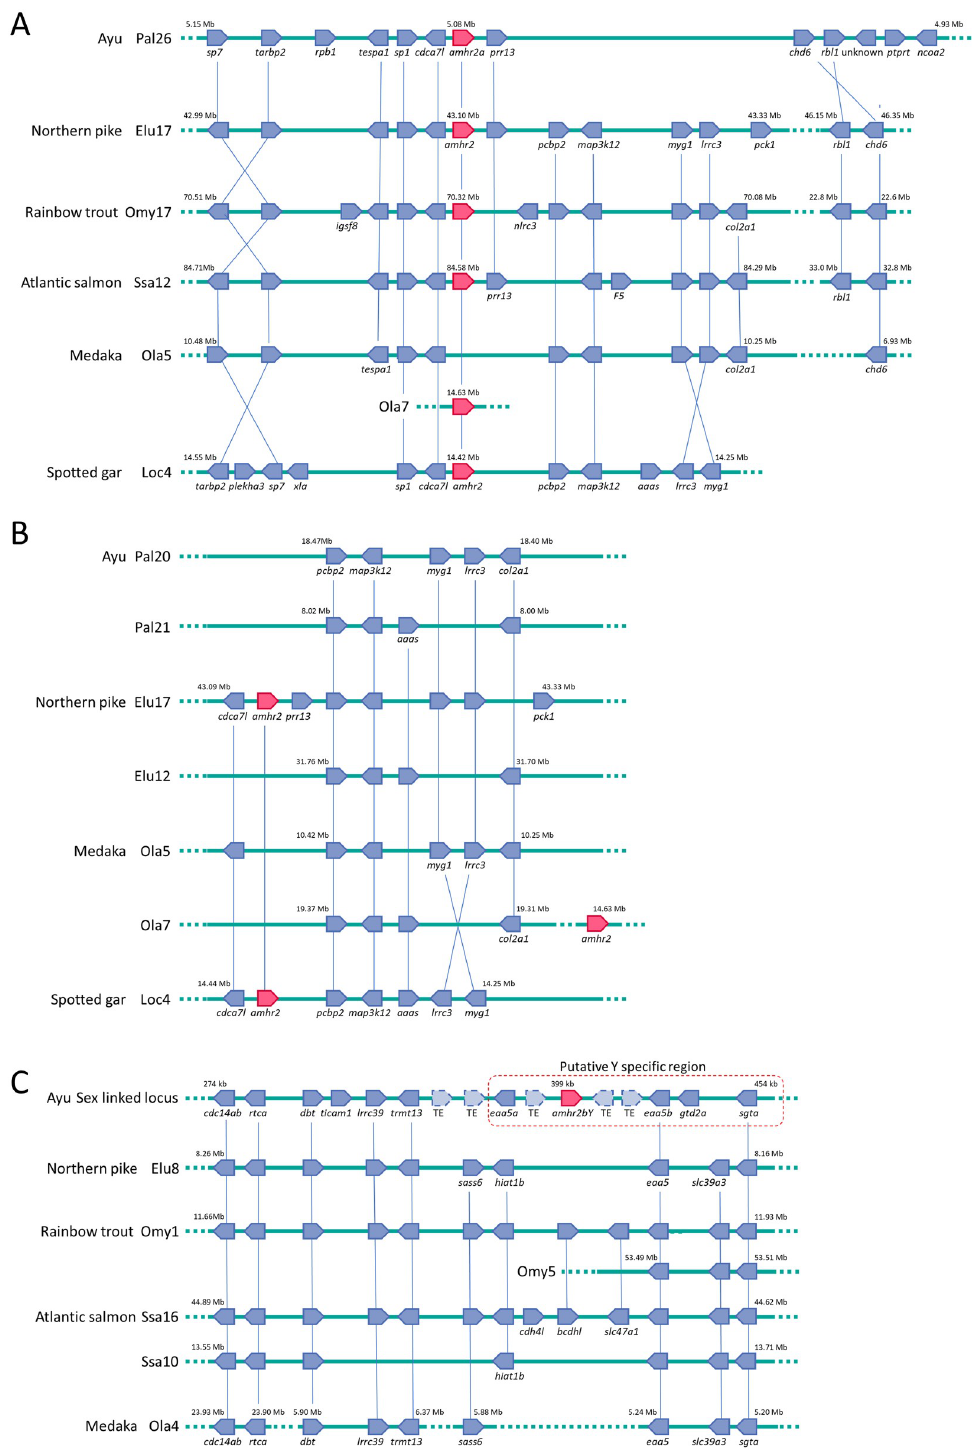
Fig 5. Summary of conserved syntenic relationships of amhr2 s between ayu and other fishes. (A) Conserved syntenic relationships of autosomal amhr2a . The region from autosomal amhr2a to sp7 on linkage group Pal26 in ayu showed conserved syntenic relationships to chromosome Elu17 in northern pike, Omy17 in rainbow trout, Ssa12 in Atlantic salmon, Ola5 excluding amhr2 in medaka and Loc4 in spotted gar. The region including pcbp2 to col2a1 was not detected in Pal26 in ayu. No conserved syntenic relationships were detected between Pal26 and medaka Ola7, which